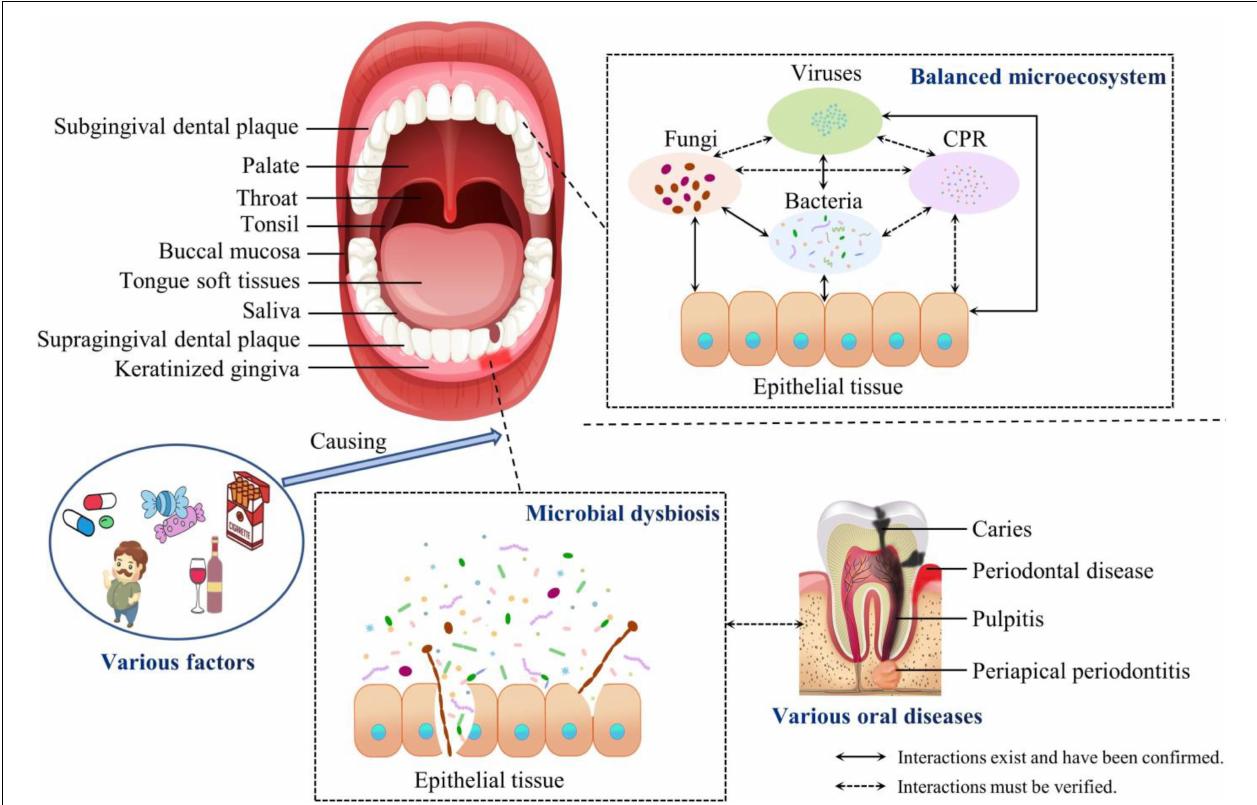
FIGURE 1 | Compositions of the balanced oral microbiota and during dysbiosis. The oral cavity is divided into nine niches. The composition of the oral microbiota and the structure of the oral biofilm adapt specifically to these different microecological environments. The communities of oral microorganisms and their interactions with the host maintain the oral microecosystem in a dynamic balance. However, various factors cause the dysbiosis of the oral microbiota, which contributes to oral and even systemic diseases. CPR, candidate phyla radiation.